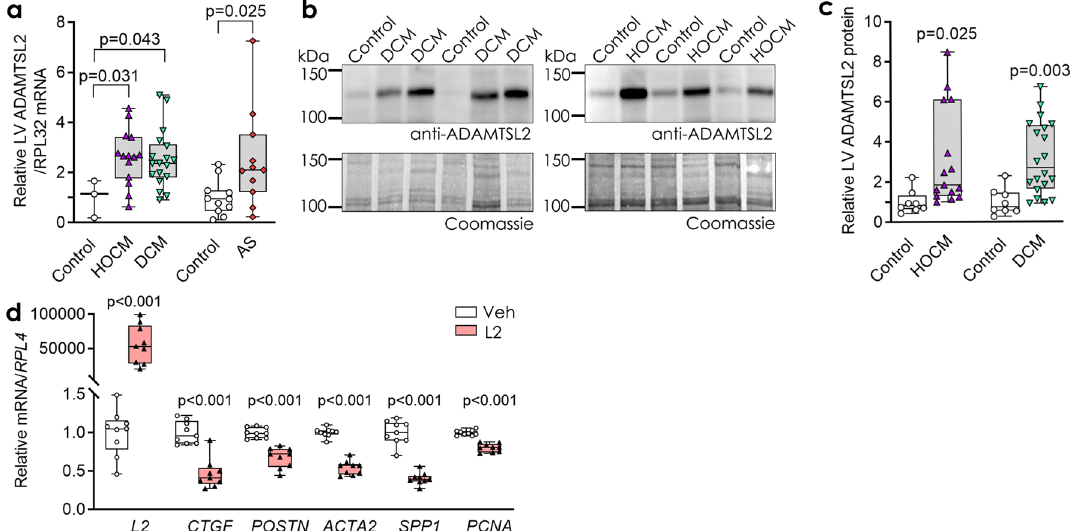
Figure 6. ADAMTSL2 is increased in left ventricles from patients with heart failure and reduces expression of pro-fibrotic genes in adult human cardiac fibroblasts. ( a ) ADAMTSL2 mRNA and ( b , c ) protein levels in left ventricles of patients with hypertrophic obstructive cardiomyopathy (HOCM, n = 15), dilated cardiomyopathy (DCM, n = 20), and aortic stenosis (AS, n = 11) vs. respective controls. Gene expression was normalized to RPL32 ( a ) and Coomassie blue staining was used as protein loading control ( b ). Uncropped blots are available in Supplementary figure V. ( d ) Human adult cardiac fibroblasts were transduced with ADAMTSL2 (L2) or control vehicle (Veh) adenoviruses. The graph shows mRNA levels of connective tissue growth factor ( CTGF ), periostin ( POSTN ), α-smooth muscle actin ( ACTA2 ), osteopontin ( SPP1 ) and proliferating cell nuclear antigen ( PCNA ) in L2 vs. Veh. Data represent experiments from three different cell passages (n = 9) and are presented as mean ± min/max values. Statistical analysis was performed using the Student t -test vs. respective